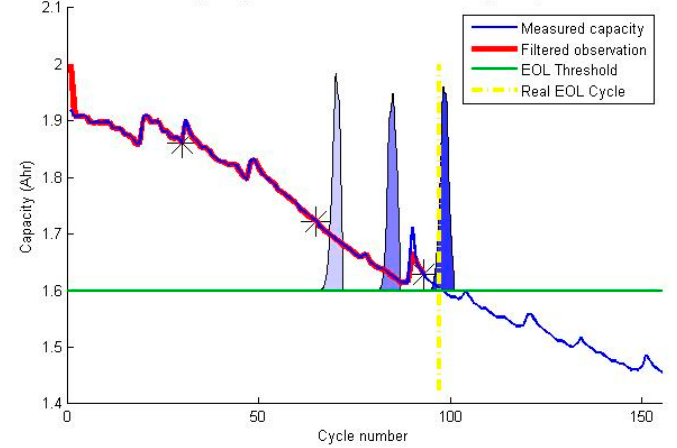
Figure 10. EOL prediction in cell B0007.